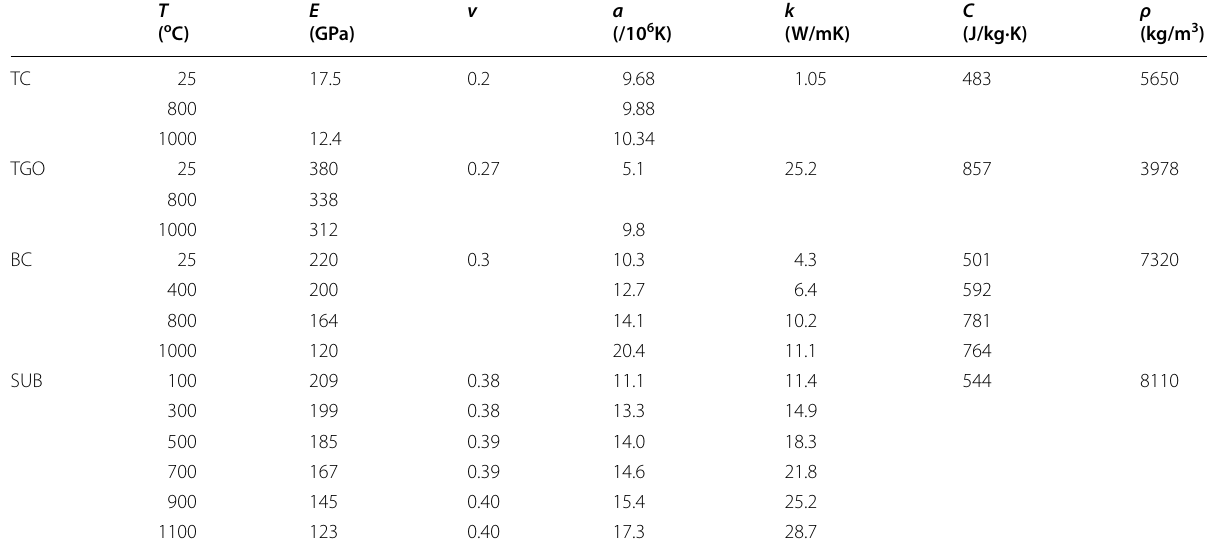
Table 1 Material properties for all layers of APS TBCs [37–41]